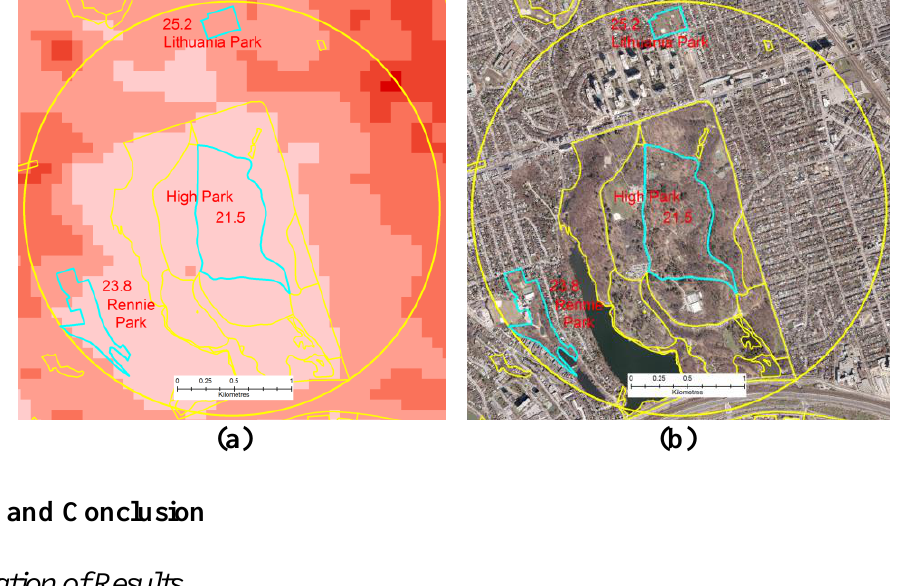
Figure 6. Neighborhood-level perspective on parks/recreation land use showing decrease in mean surface temperature as polygon size increases. (a) Parks/recreation polygons overlaid on surface temperature; (b) orthophoto for